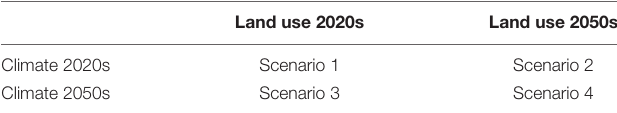
TABLE 2 | Land use and climate scenario